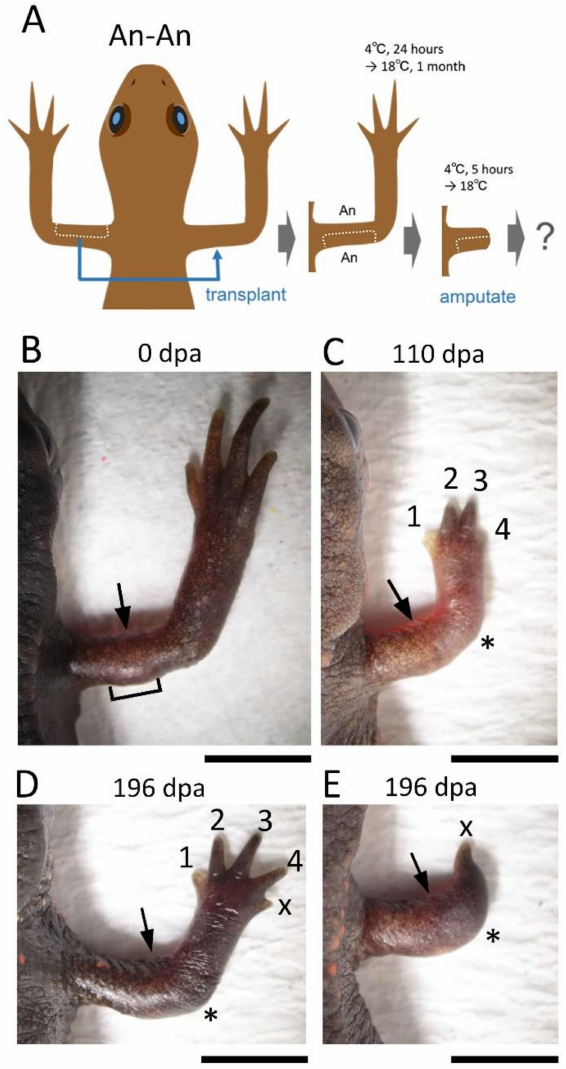
Figure 3. Effects of Anterior-Anterior (An-An) skin grafting on limb regeneration. ( A ) Schematic showing the surgical process. ( B , C ) Representative showing normal regeneration (n = 13). Bracket: grafted skin. ( D , E ) Rarely occurring abnormal limbs. ( D ) A limb with a 5-digit hand (n = 2). ( E ) A limb with a 1-digit hand at the tip (n = 1). The number near the digit indicates digit number. X indicates the digit whose number could not be determined. The asterisk indicates the elbow. The arrow indicates the amputation position. dpa: day post amputation. Scale bars: 5